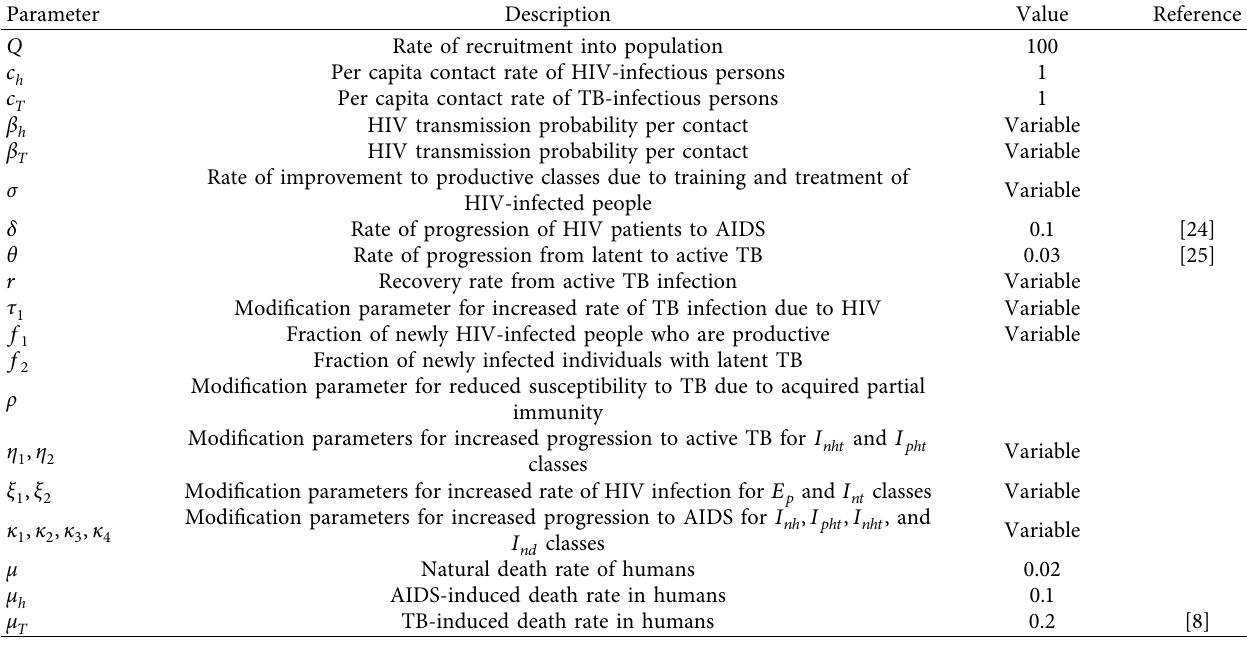
Table 1: Description of model parameters and baseline